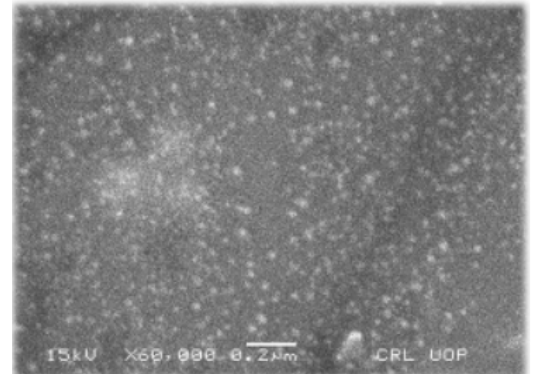
Fig. 3. SEM photomicrograph of copper nanoparticles at 15 kv x 60,000